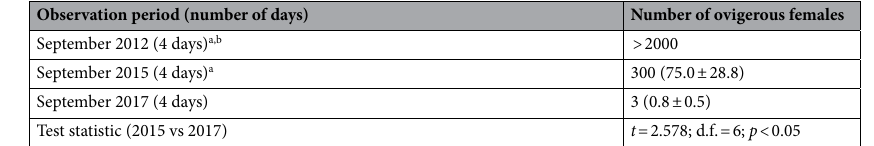
Table 2. Total number of ovigerous females and mean number of ovigerous females recorded per day (in parentheses) of Metasesarma aubryi at the Hsiangchiaowan–Shadao area during the peak breeding season. a Data for 2012 and 2015 were obtained from Liu, unpublished data and Liu 38 , respectively. b Data regarding mean number of ovigerous females recorded per day for the year 2012 are not available.